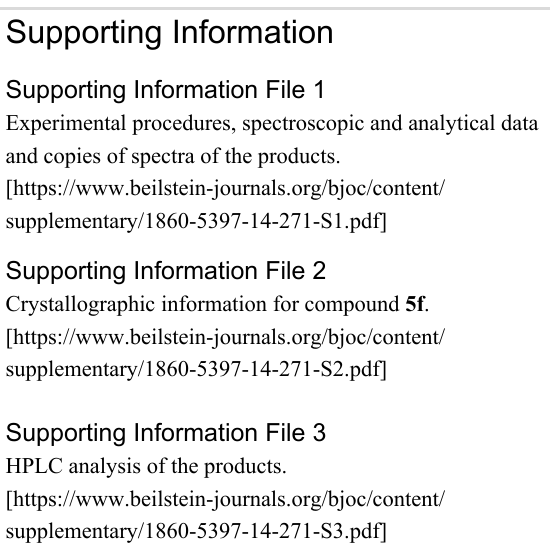
ingly, acidic (phenolic 5j ) and basic moieties (as indolyl 5i )